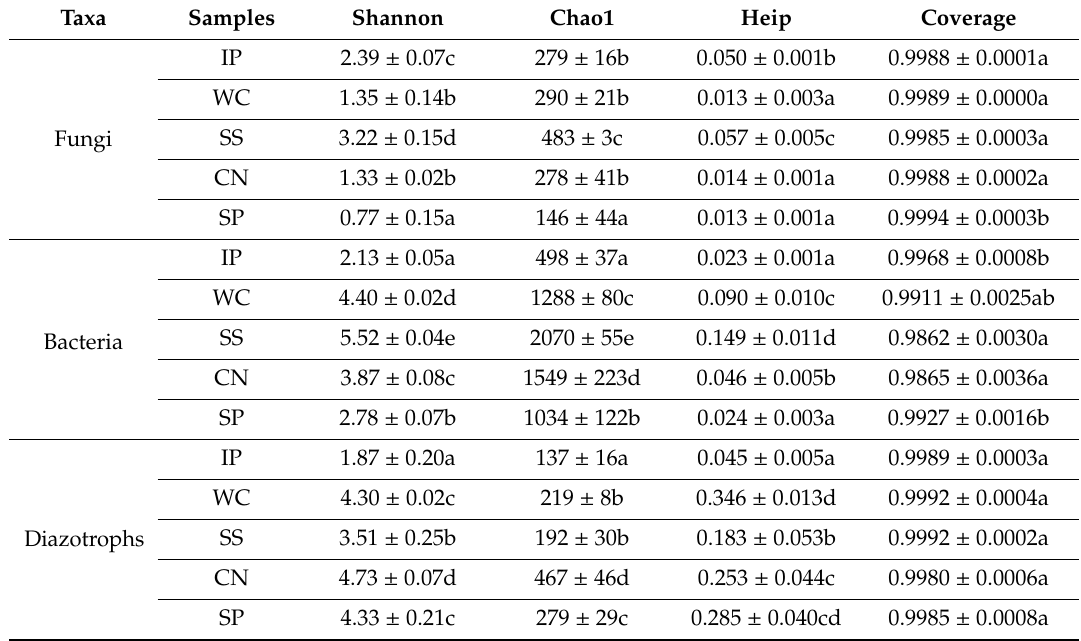
Table 1. Alpha-diversity of microbes between di ff erent phyllosphere